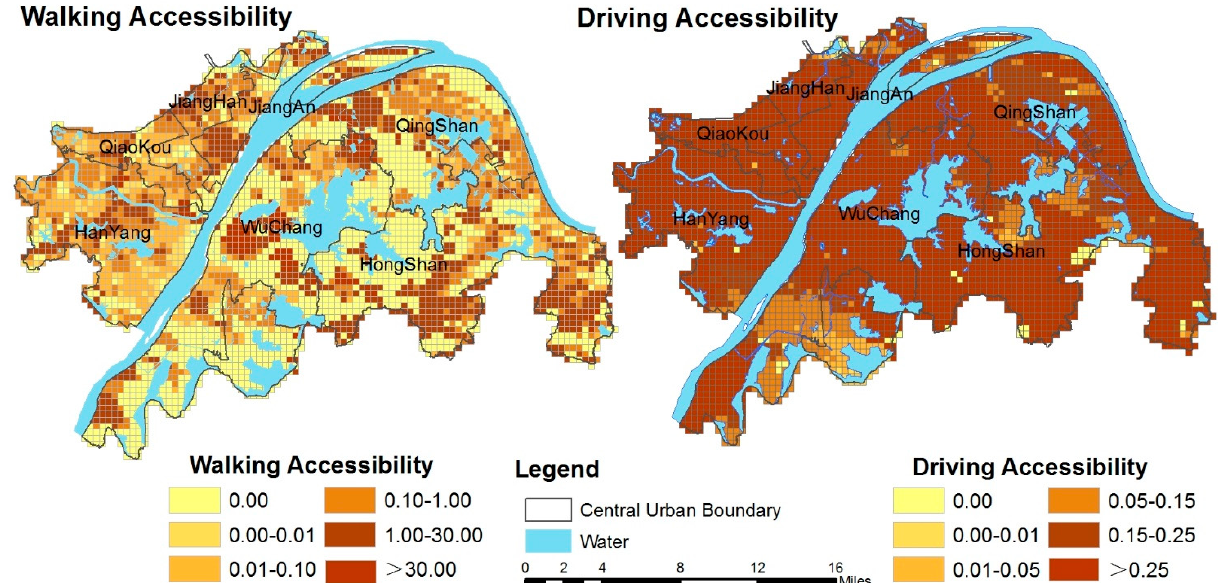
Figure 2. Spatial distribution of the accessibility of PGSs in the central urban area of Wuhan.